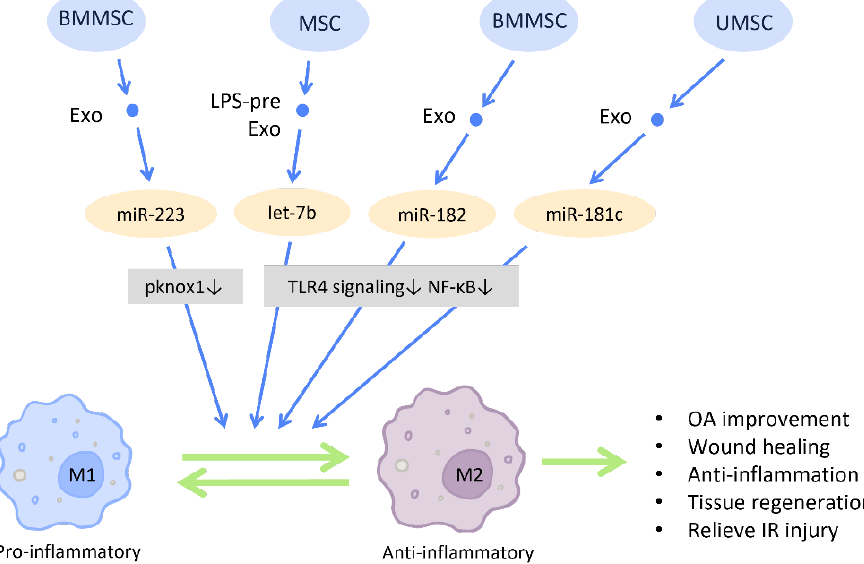
Figure 9. Immunomodulation by stem cell-derived exosomes in macrophage polarization. Immunomodulation by stem cell-derived exosomes in macrophage polarization. MSC-Exos have the capacity to direct macrophages from a pro-inflammatory phenotype (M1) toward an anti-inflammatory phenotype (M2), which in turn aids in the reduction of inflammation, tissue remodeling, and wound healing. Abbreviation: Exo: exosome; LPS-pre: lipopolysaccharide-preconditioned; MSC: mesenchymal stem cell; BMMSC: bone marrow MSC; UMSC: umbilical cord MSC; miR: micro-RNA; M1: M1 macrophage; M2: M2 macrophage. ↑ represents upregulation; ↓ represents downregulation.